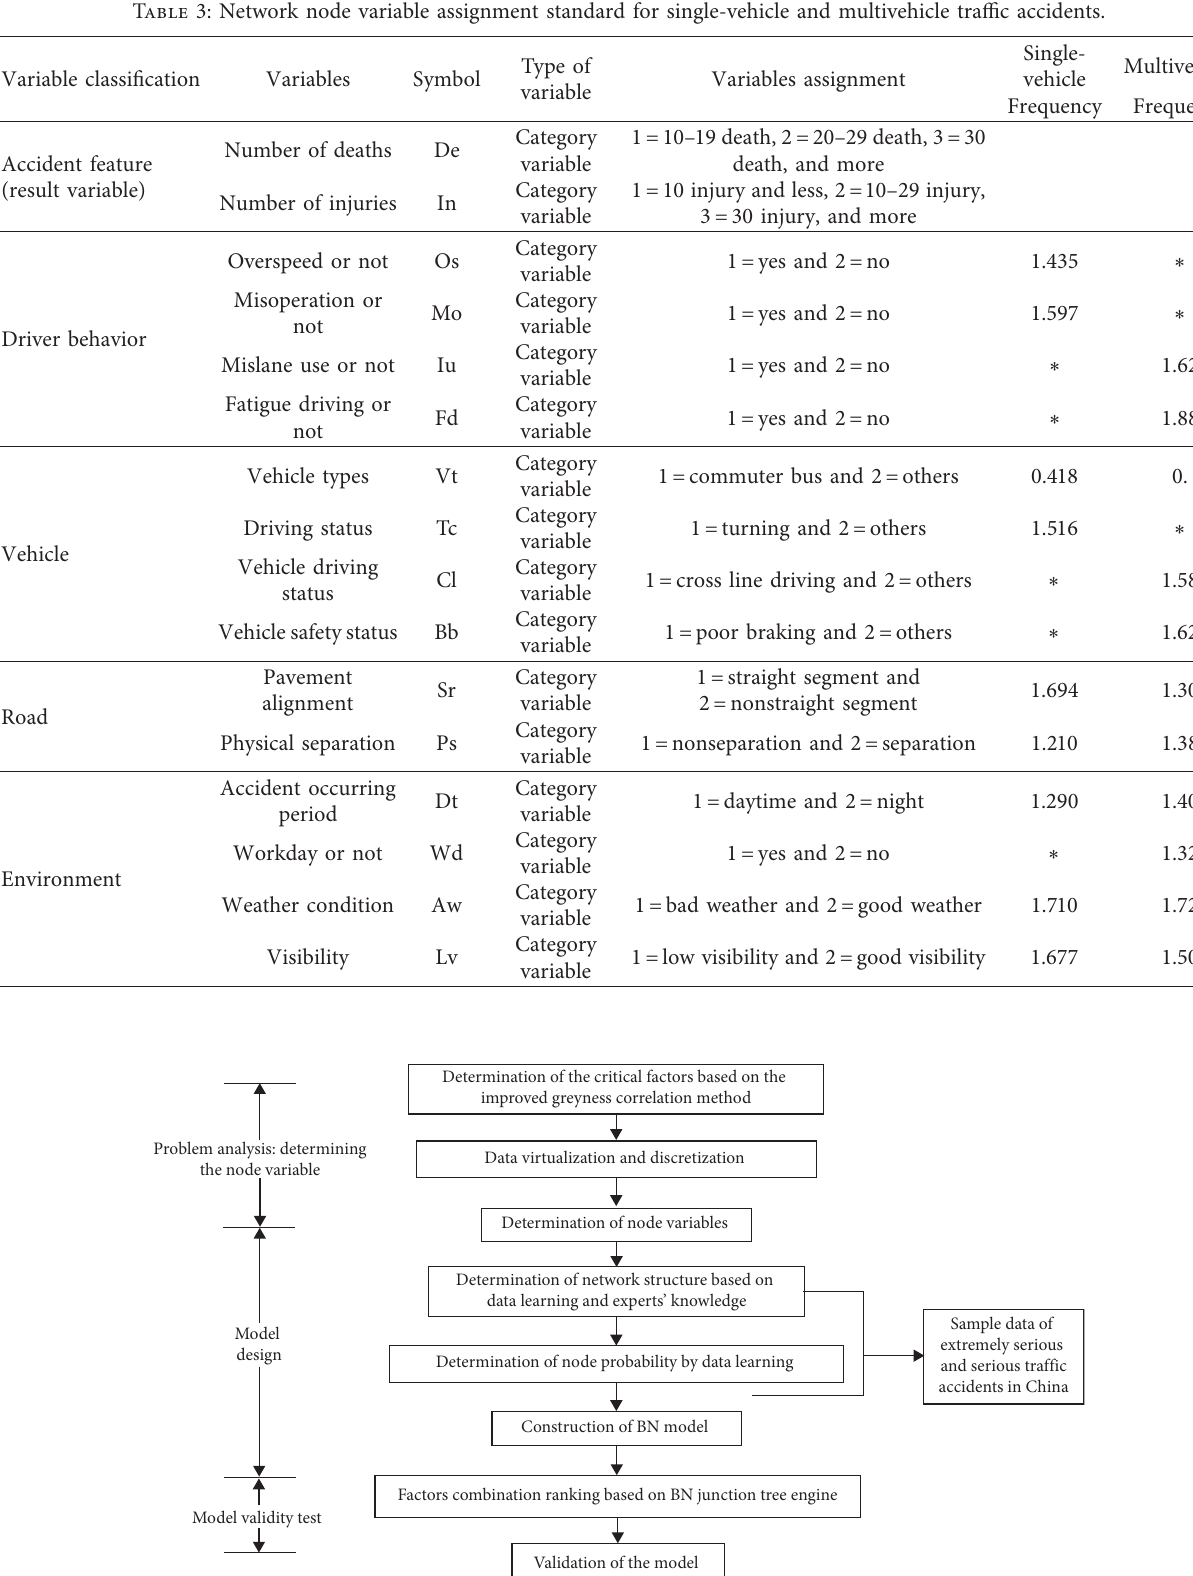
Table 3: Network node variable assignment standard for single-vehicle and multivehicle traffic accidents.